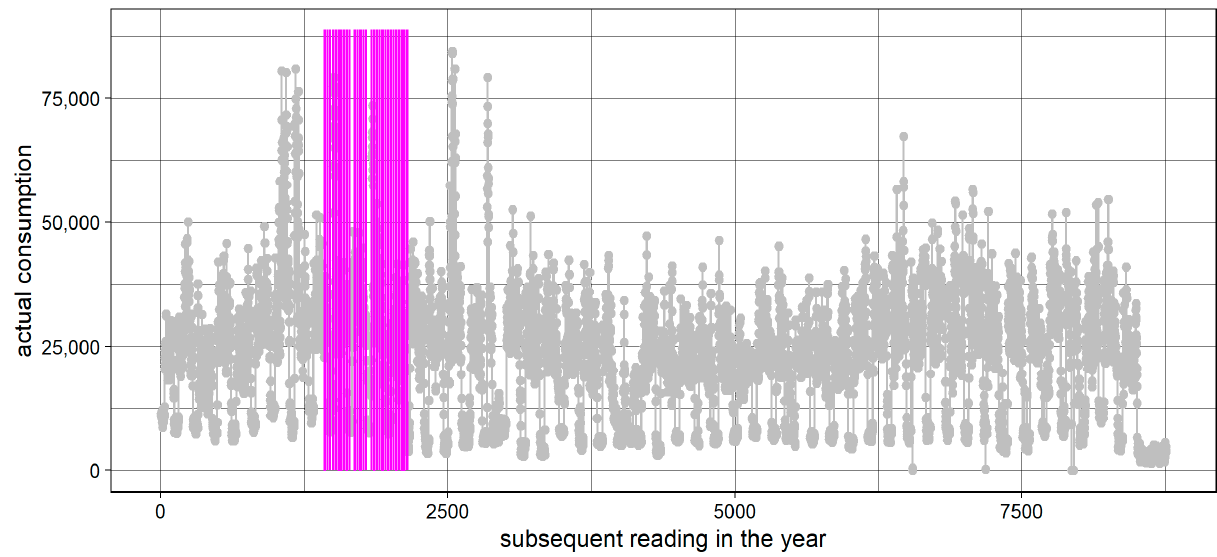
Figure 3. PPE-Example2—course of the series with marked missing data (48 missing values, 29 gaps, the longest sequence of missing values: 2). Source: own elaboration.